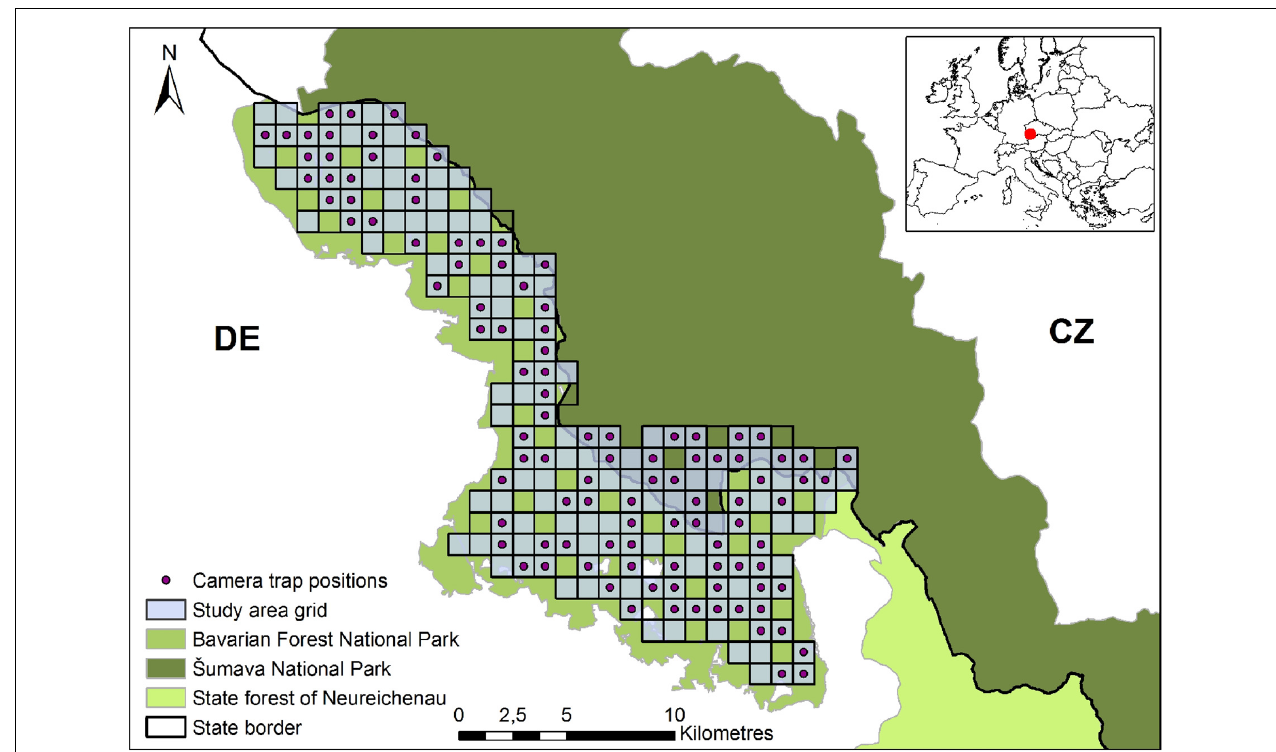
FIGURE 2 | Locations of the camera trap positions within the study area grid, located at the border of Germany (DE) and Czechia